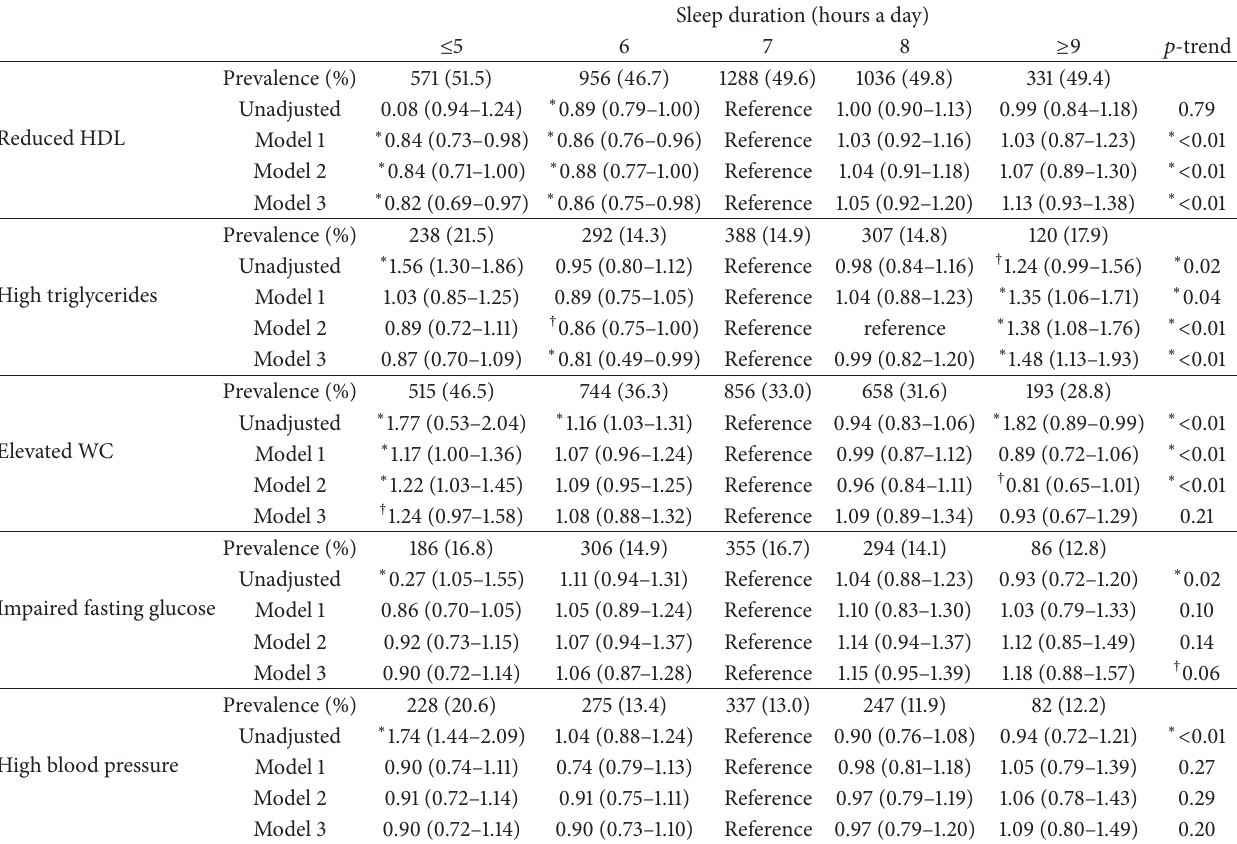
Data of prevalence category are numbers and percentages. The metabolic syndrome was defined using the National Cholesterol Education Program-Adult Treatment Panel III criteria. Model 1, adjusted for age, education, and monthly income. Model 2, adjusted for smoking and alcohol status, physical activity, and energy intake plus Model